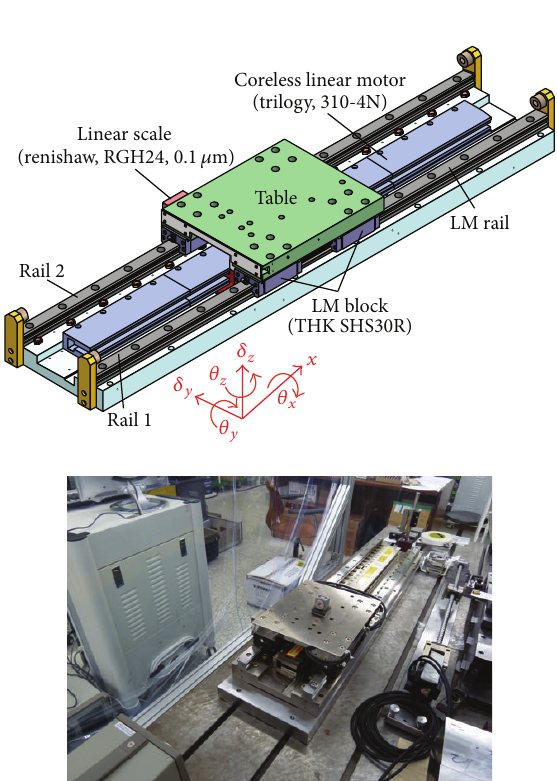
Figure 10: The linear motion bearing stage used in the experiments.